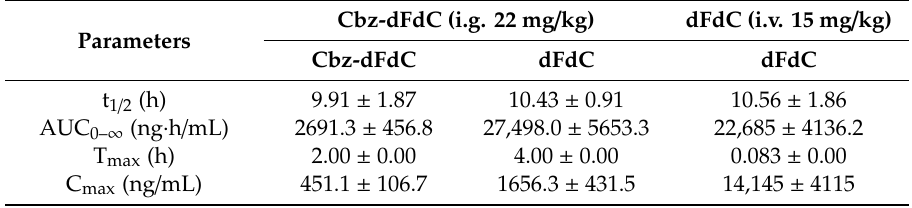
Figure 2. The plasma concentrations of Cbz-dFdC and dFdC in rats, ( A ) after i.g. administration of Cbz-dFdC (22 mg / kg); and ( B ) after i.v. administration of dFdC (15 mg / kg). Table 1. Pharmacokinetic parameters of Cbz-dFdC and